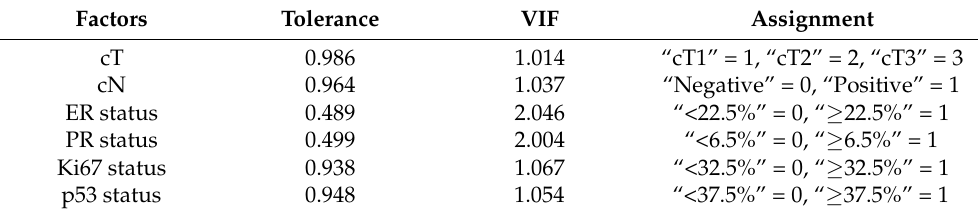
Table 2. Multicollinearity test of predictive factors and the approach to assigning